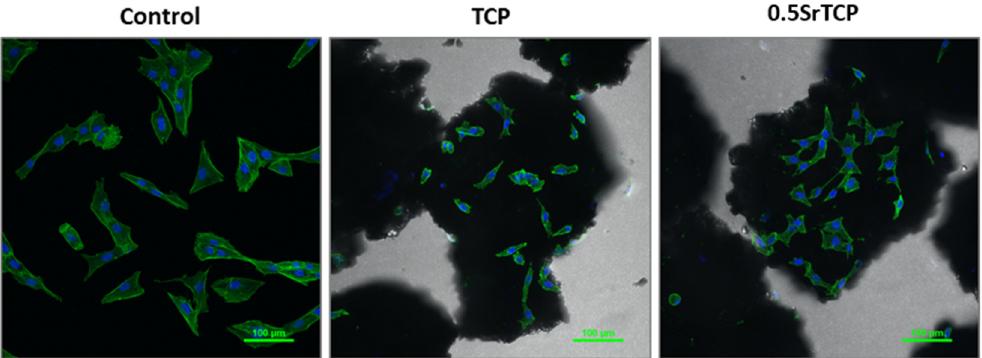
Figure 12. Confocal fluorescence microscopy of MG-63 cells in direct contact with TCP and 0.5SrTCP ceramics (24 h of cell growth, monochrome images of FITC conjugated Phalloidin ( green ) and DAPI (nuclei, blue )).